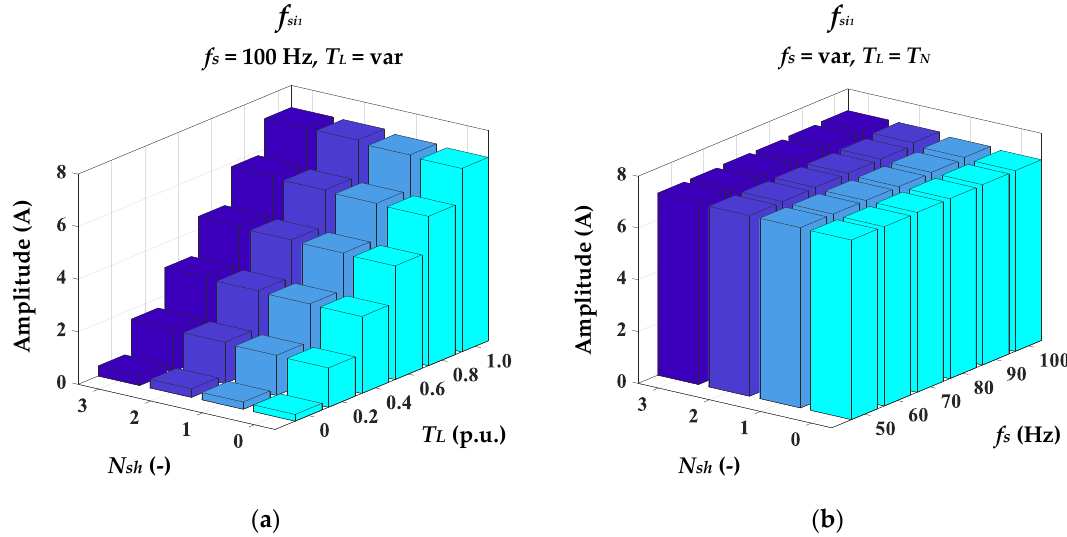
Figure 4. The impact of shorted turns number in the PMSM stator winding on the level of the amplitude of the f si 1 component in the positive phase current sequence component for variable load torque T L ( a ) and variable supply frequency f s ( b ).